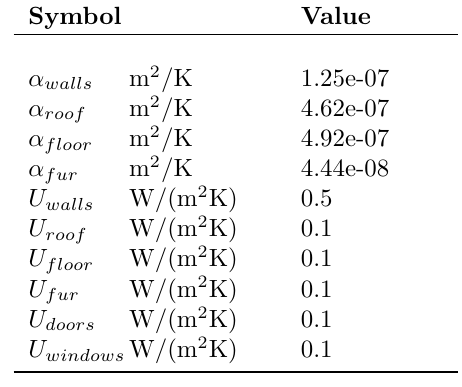
Table 1: Parameter specification for single-zone model